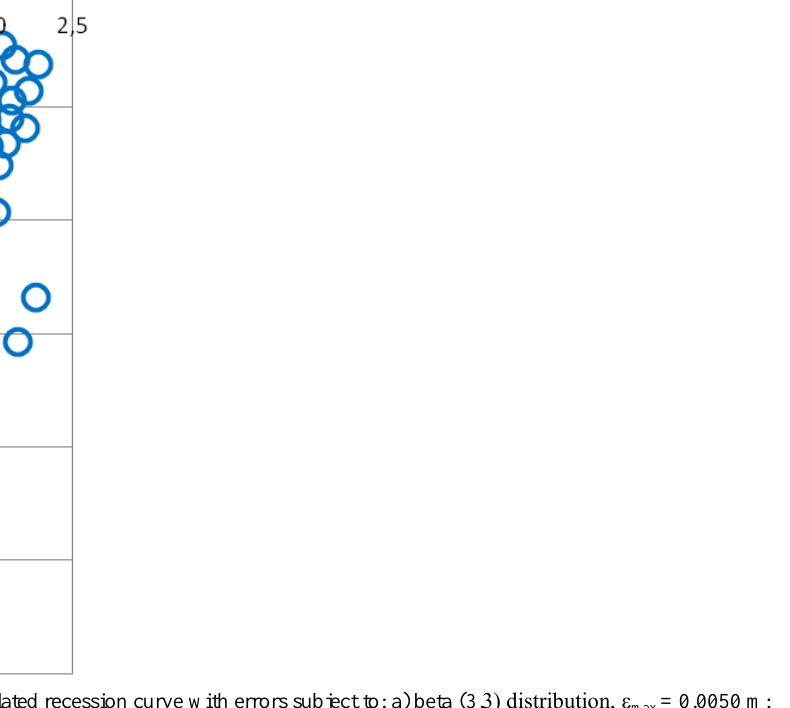
Fig. 2. Results of BN77 analysis of the simulated recession curve with errors subject to: a) beta (3,3) distribution, ε max = 0.0050 m; b) normal distribution N(0, 0.0025 m); c) beta (3,3) distribution, ε max = 0.010 m; d) normal distribution, N(0, 0.0050 m). Red line in b) shows the increasing slope of the lower envelope at high